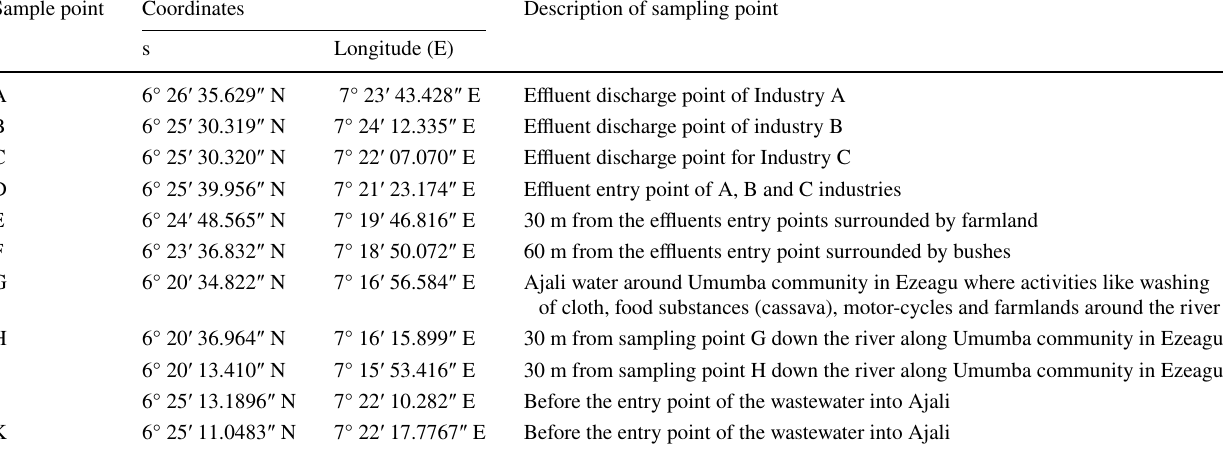
Table 1 Sample points and their coordinates Sample point Coordinates Description of sampling